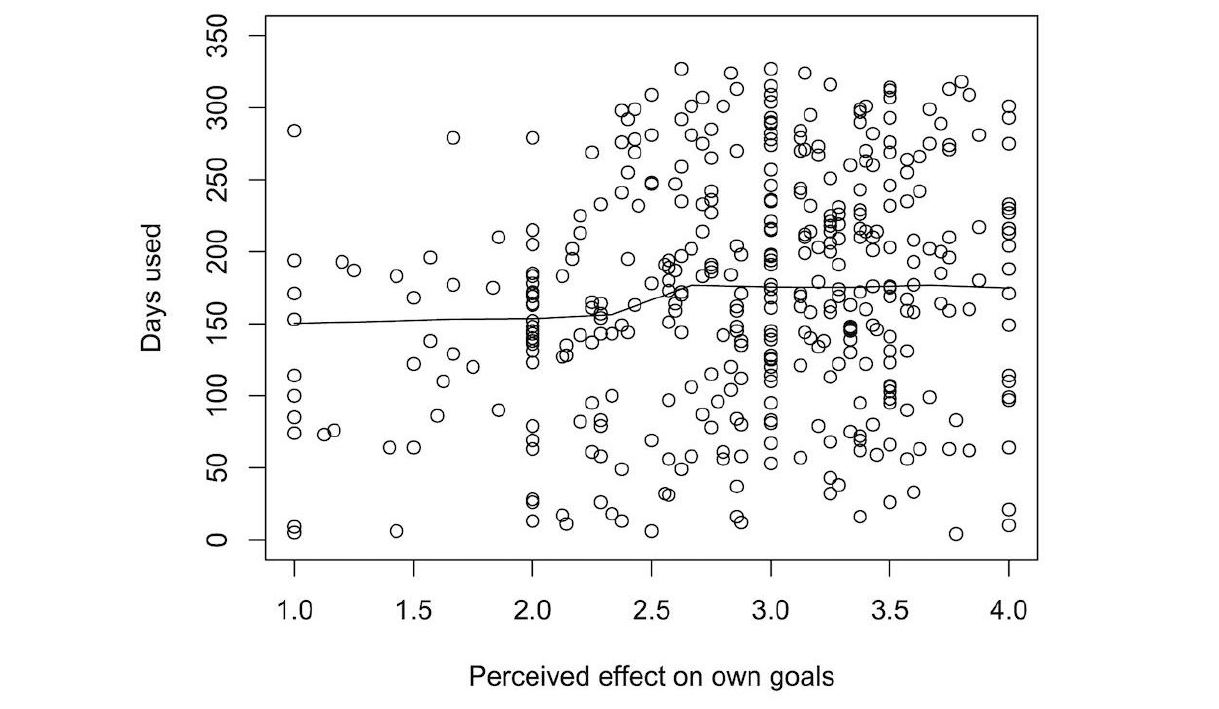
Figure 13. Plot of the partial dependence of sustained tracker use on the perceived effect of the tracker on goal attainment. A larger perceived effect leads to longer sustained